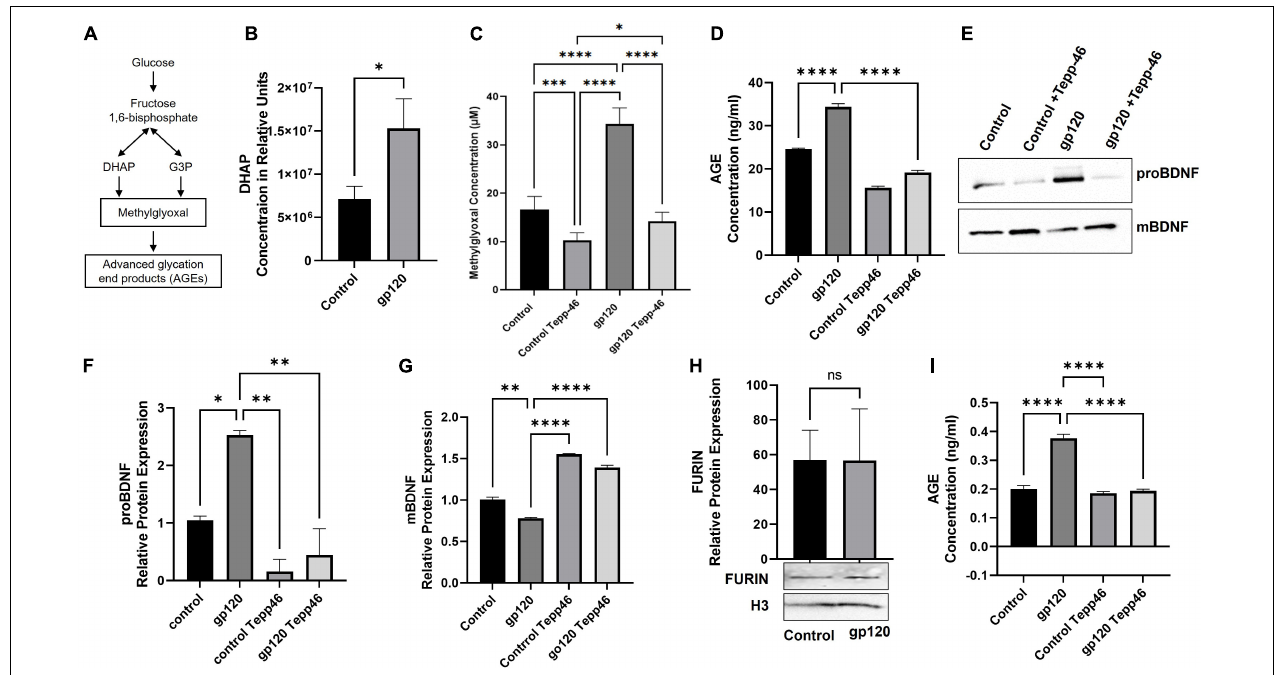
FIGURE 8 | Altered expression of proBDNF, BDNF, and AGE in gp120-treated cells. (A) Schematic representation of advanced glycation end products (AGEs) pathway activation. (B) Dihydroxyacetone phosphate (DHAP) relative concentration as obtained by MetaboAnalyst 5.0 online software ( ∗ p < 0.05). (C,D) Differentiated LUHMES cells untreated or treated with 100 ng/ml of gp120 and/or 10 nM of Tepp-46. The cellular concentration of methylglyoxal (MG) ( µ M) and AGEs (ng/ml) were measured by ELISA, samples were normalized to dilution factor and cell count. (E) Differentiated LUHMES cells untreated or treated with 100 ng/ml of gp120 and/or 10 nM of Tepp-46. 250 µ g of cell extracts were used for immunoprecipitation using anti-proBDNF or -BDNF antibodies followed by Western analysis as shown. (F,G) Quantification of the relative protein levels was determined from the band intensity using ImageJ software. Bar graphs represent means ± S.D. (H) Expression of furin protein isolated from untreated or gp120-treated LUHMES for 8 h as obtained by Western blot. Quantification of the relative protein levels was determined from the band intensity using ImageJ software and normalized relative to the H3. (I) AGEs concentration was measured via ELISA on IP pull-down of BDNF from these samples. Data represent the mean ± S.D. (I) Data represent the mean ± S.D. Results were judged statistically significant by ANOVA ( ∗ p < 0.05, ∗∗ p < 0.01, ∗∗∗ p < 0.001, ∗∗∗ p < 0.0001).